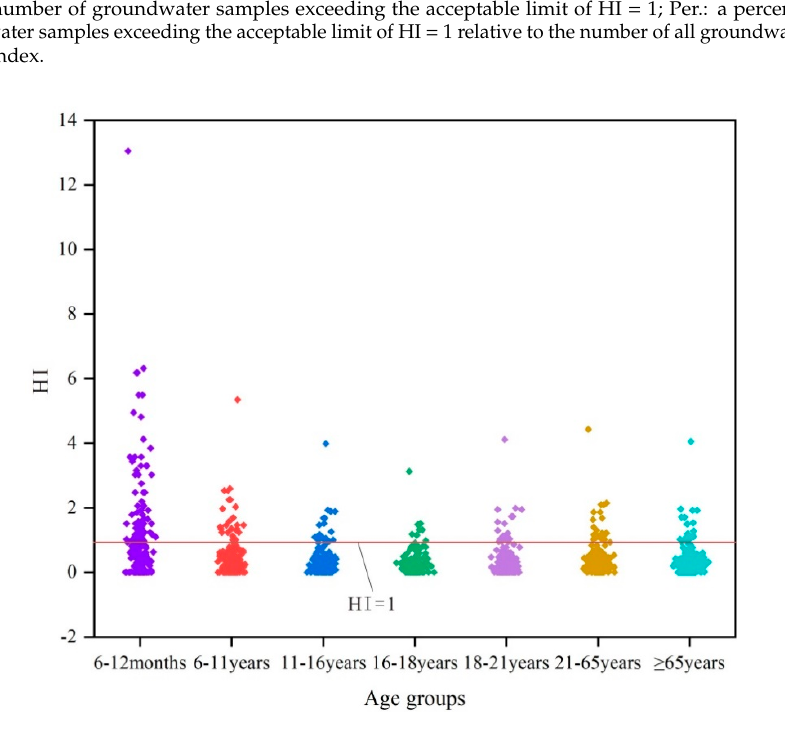
Figure 7. The results of non-carcinogenic health risk for different age groups.